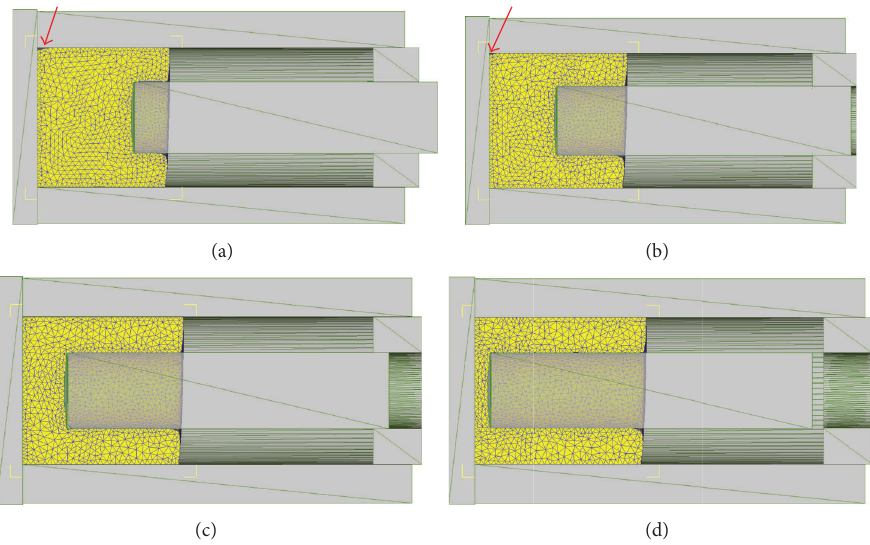
Figure 8: Piercing extrusion process at (a) 90mm, (b) 180 mm, (c) 270 mm, and (d) 360